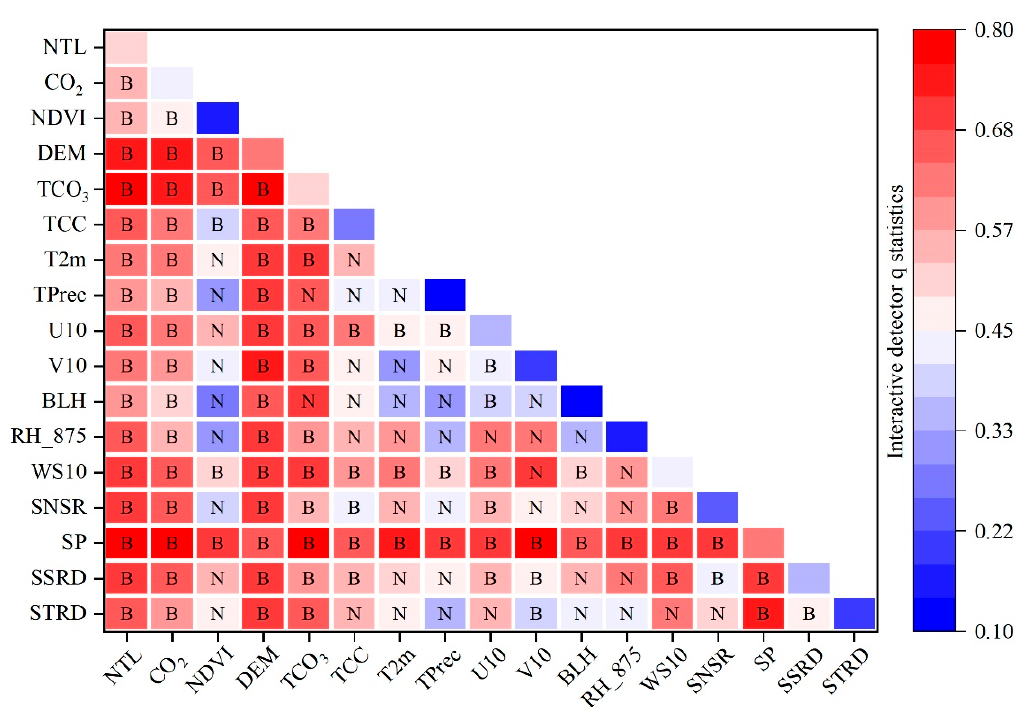
Figure 7. The interactive enhancement of potential impact factors on NO 2 VCD of the YREB in 2019 (N and B represent nonlinear enhancement and bivariate enhancement, respectively).